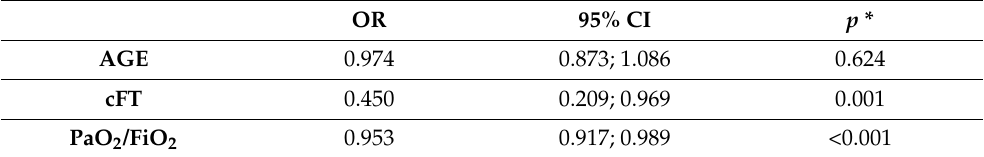
Table 3. Multivariable logistic regression for CPAP Therapy using